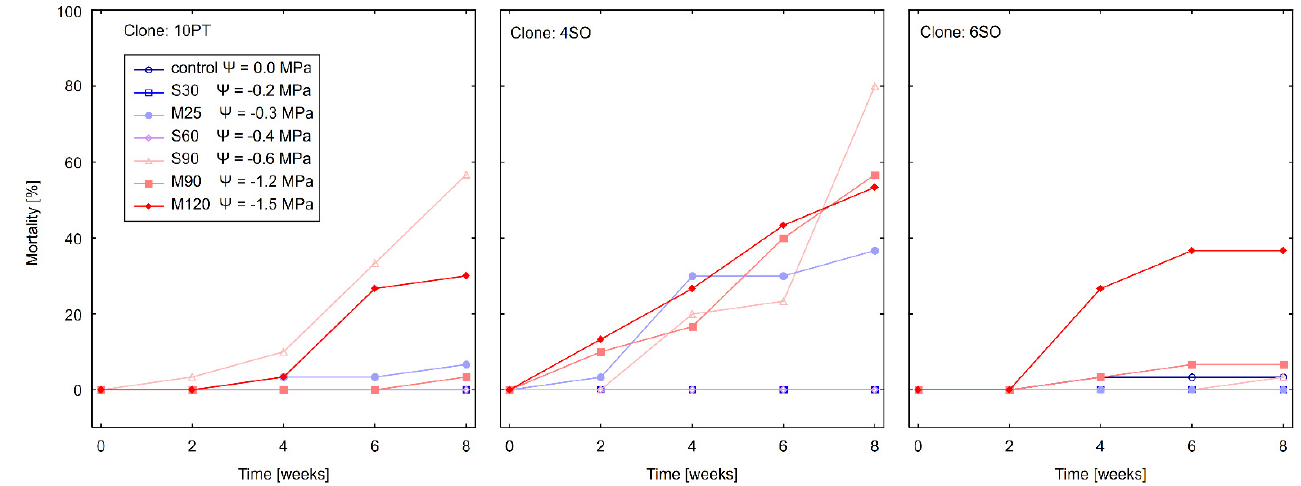
Means with the same lowercase letter within a column or means with the same uppercase letter within a row are not significantly different at p ≤ 0.05; SE—standard error.